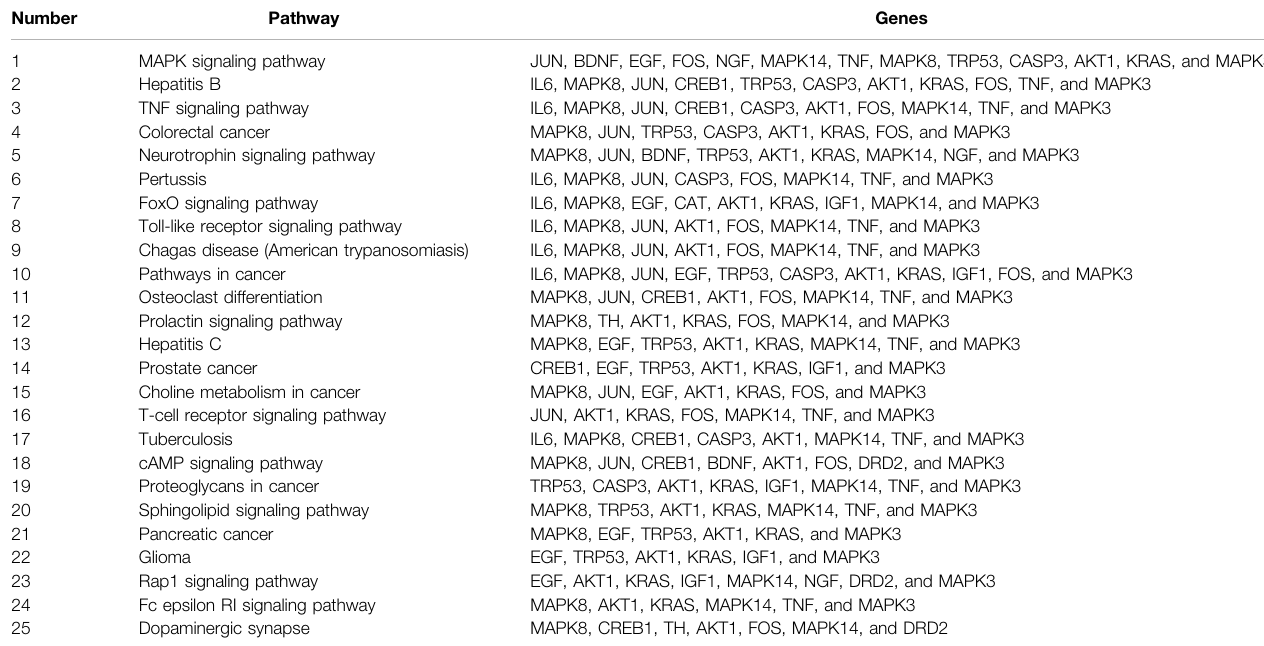
TABLE 2 | Top 25 signi fi cantly enriched pathways of hub